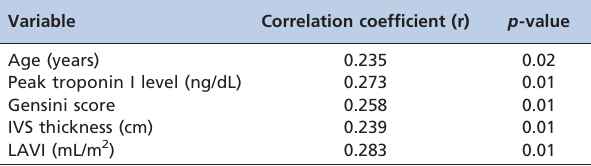
Table 4 - Correlations of NT-proANP with other variables in patients with acute STEMI.